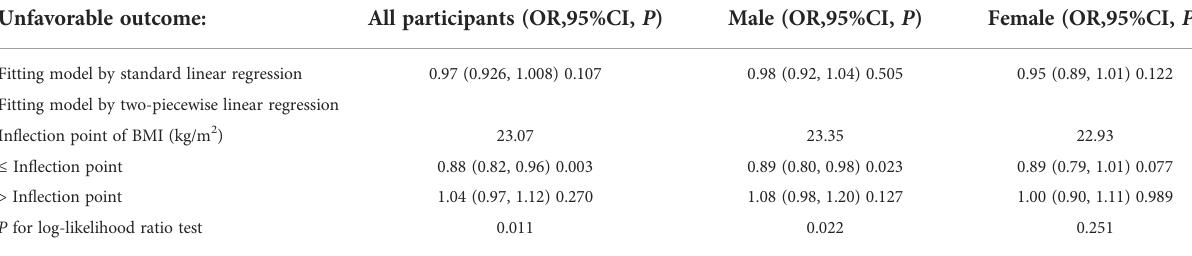
TABLE 4 The results of two-piecewise linear regression model. Unfavorable outcome: